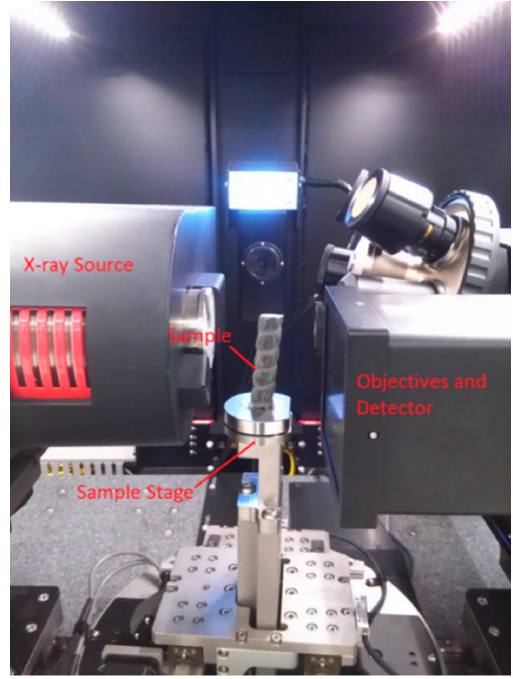
Figure 2. Zeiss 410 Versa XRM and the sample fixed in position .